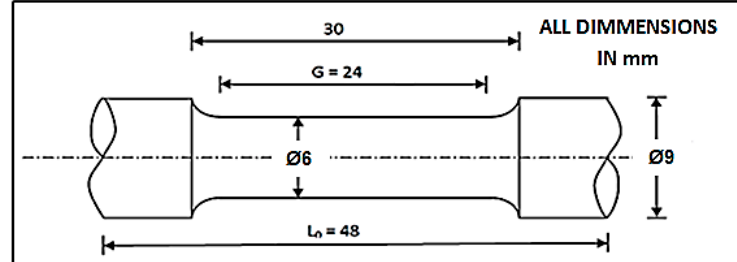
Figure 3. Tensile specimen as per ASTM-E8M.